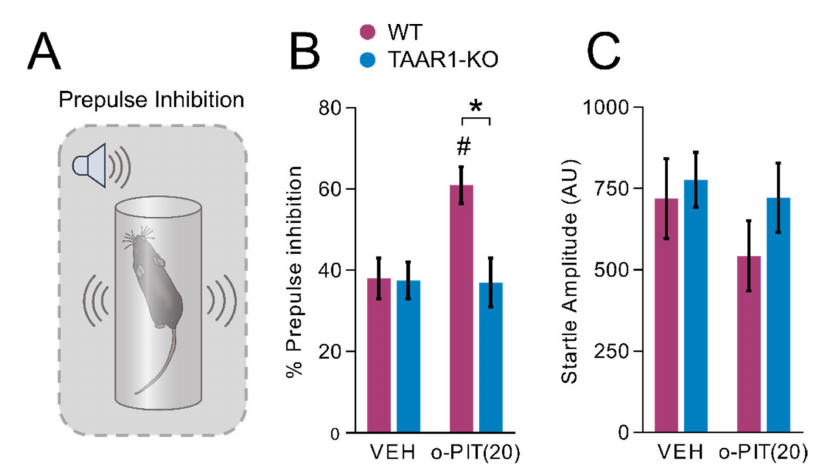
Figure 3. Influence of o-PIT on prepulse inhibition in TAAR1-KO and WT mice. ( A ) Schematic depiction of prepulse inhibition experiment. ( B , C ) Show that the enhancement by o-PIT of prepulse inhibition ( B ) is specific in that it does not affect the startle reflex, per se, neither in WT nor in TAAR1-KO mice ( C ). Data represent means ± SEM. N = 8–12 per group. p < 0.05, influence of treatment (#) or genotype (*). VEH: